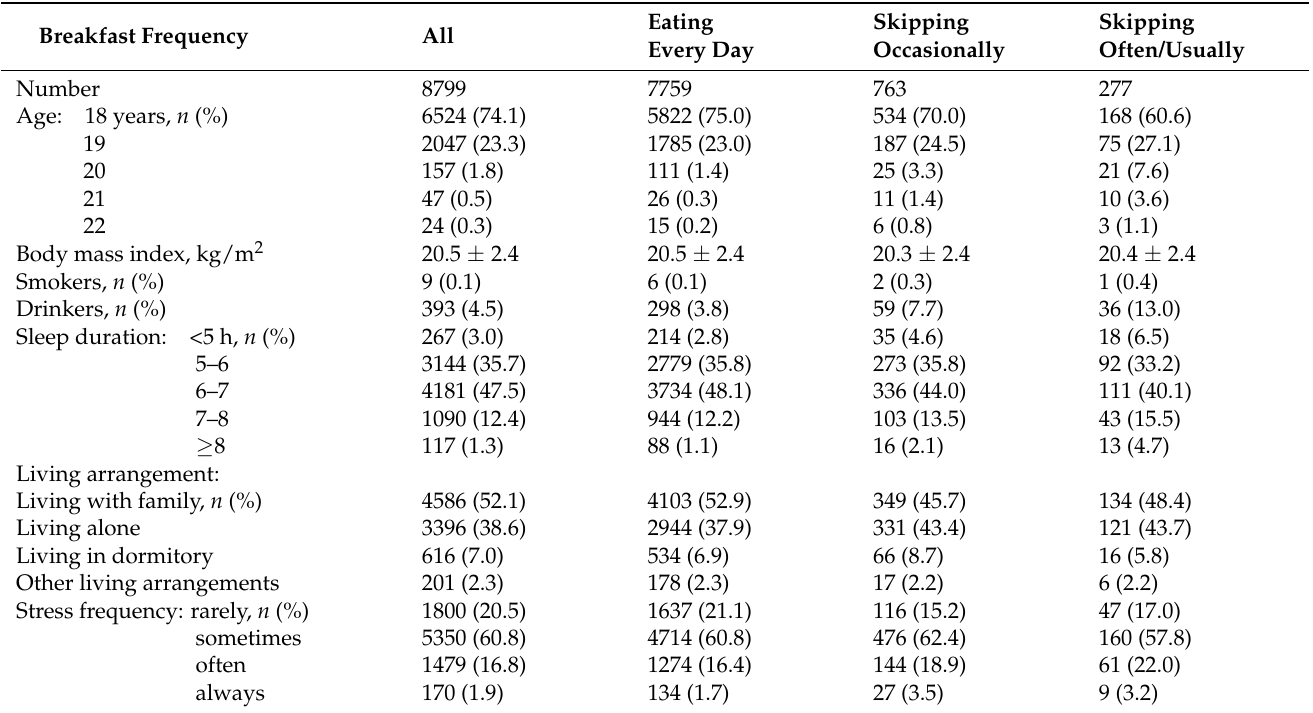
Table 2. Baseline characteristics of 8799 female university students stratified by breakfast